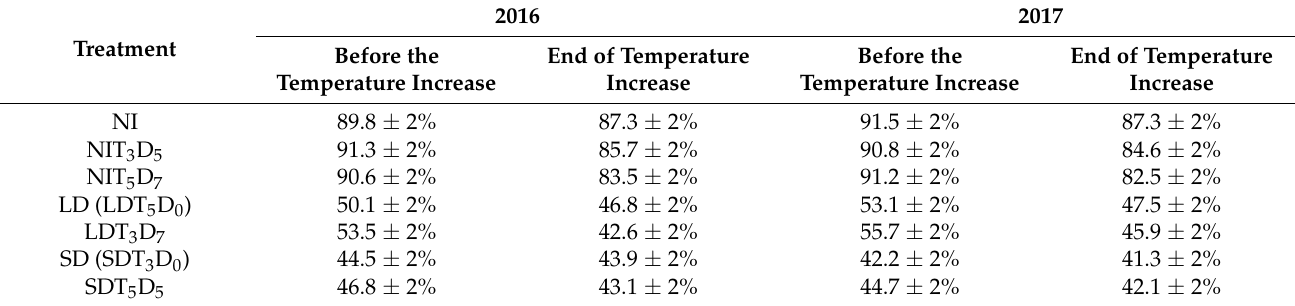
Table 4. Soil water relative content (%) before and after temperature